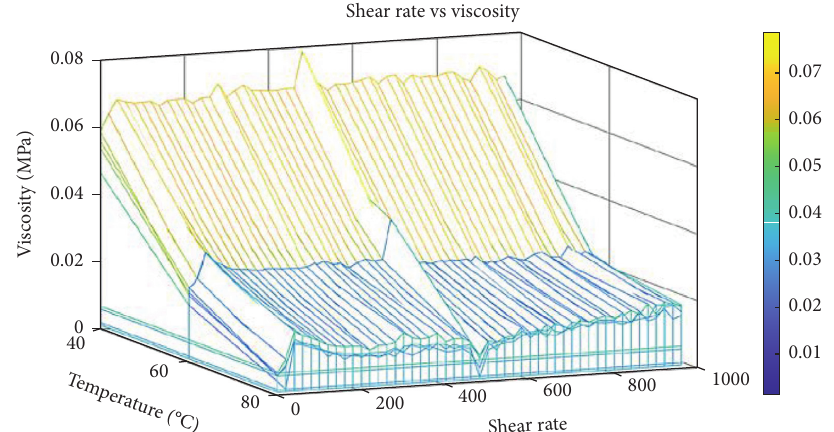
Figure 18: Plot of viscosity to shear rate.